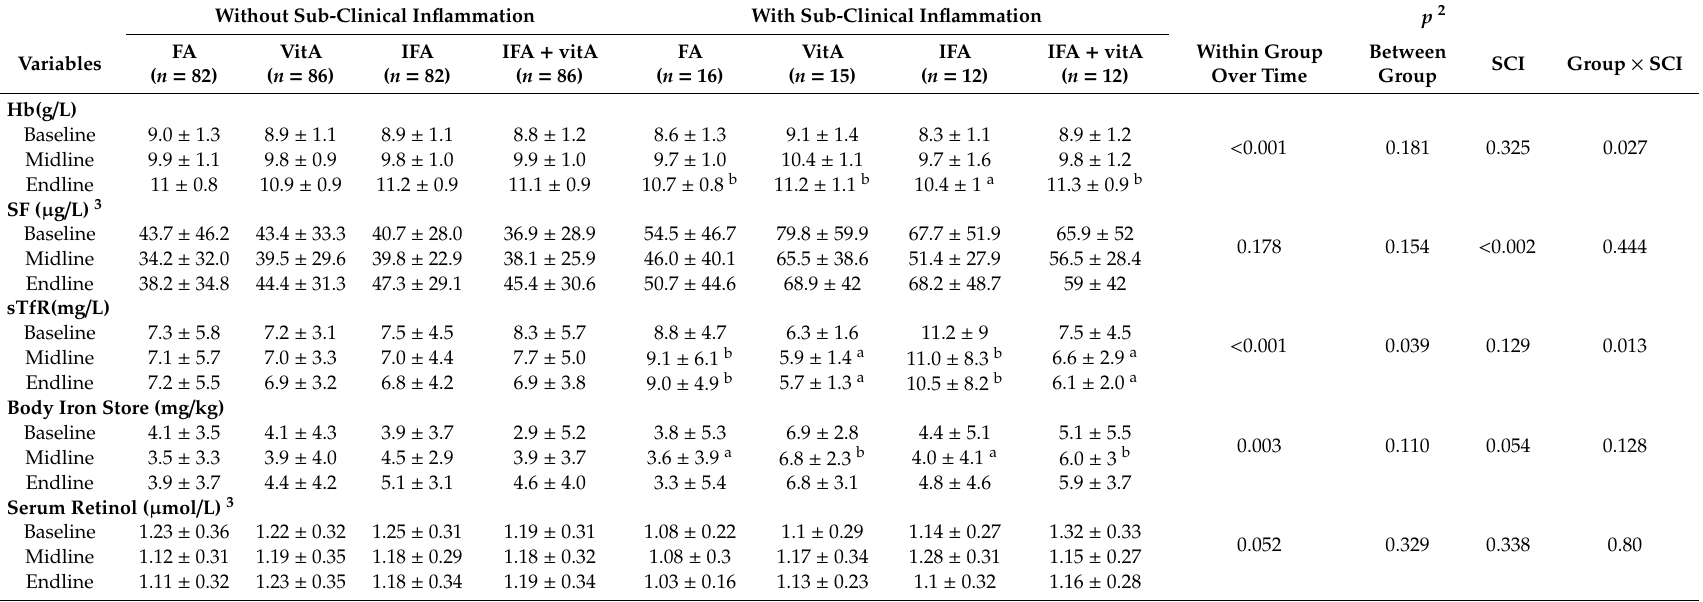
Table 4. E ff ect of iron and vitamin A supplementation in the presence and absence of sub-clinical inflammation among the adolescent girls during 12 weeks of intervention 1